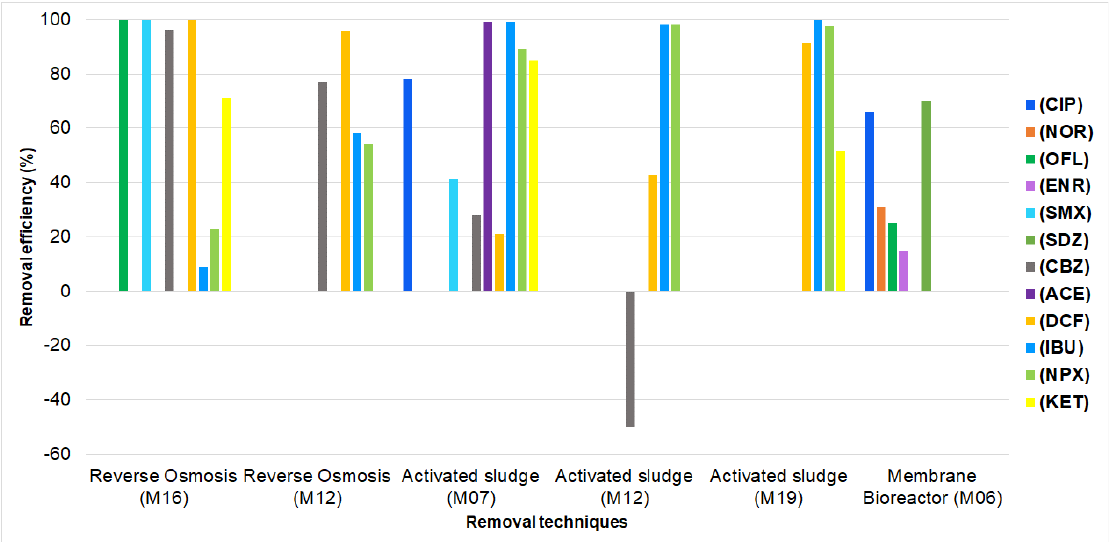
Figure 7. Removal of pharmaceuticals from municipal wastewater in studies with a pre-experi- mental design (M16 = [48], M12 = [41], M07 = [33], M12 = [41], M19 = [51], M06 = [32]).